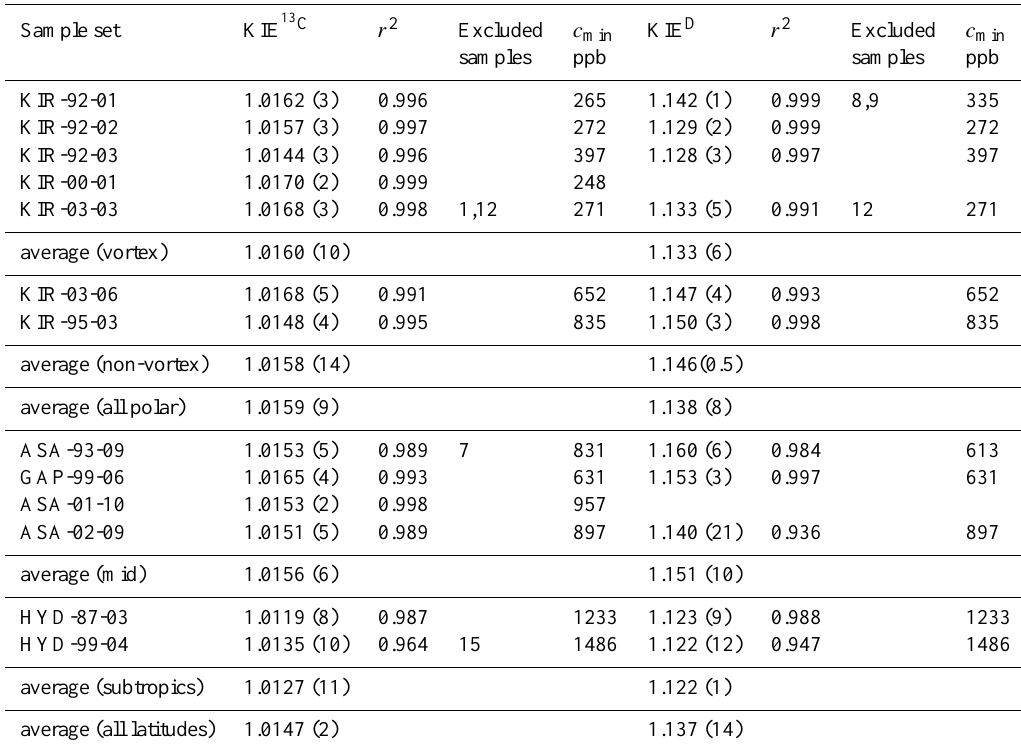
Table 3. Mean KIE per flight, in brackets error on last digits. Additionally the column “ c min ” shows the minimal mixing ratio in a sample set used to derive the corresponding mean